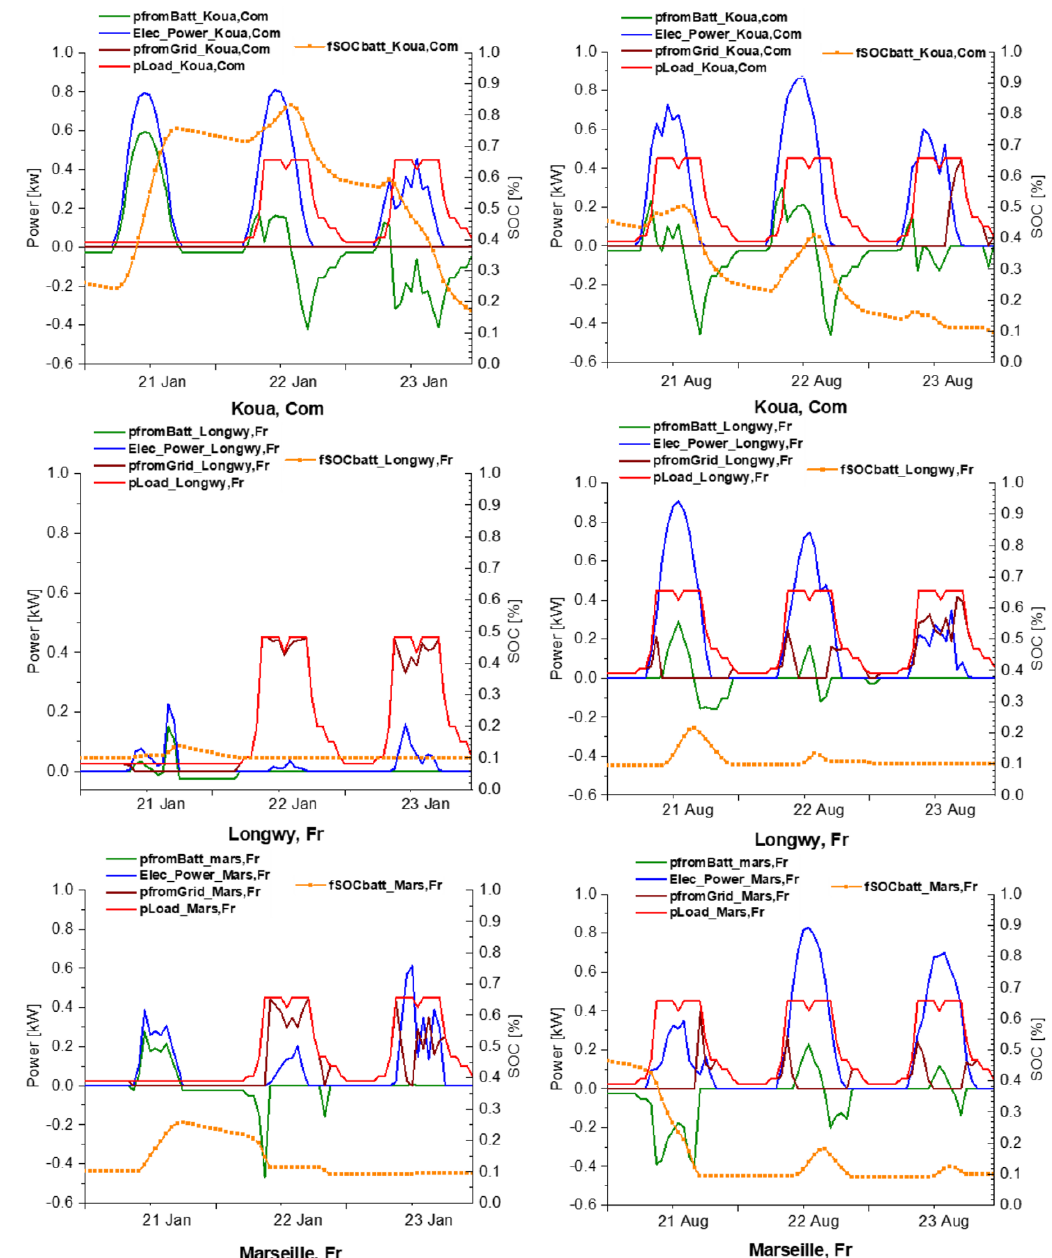
Figure 7. Electrical power produced, consumed, or stored during three typical days in January and August at Koua, Marseille, and Longwy. August at Koua, Marseille, and